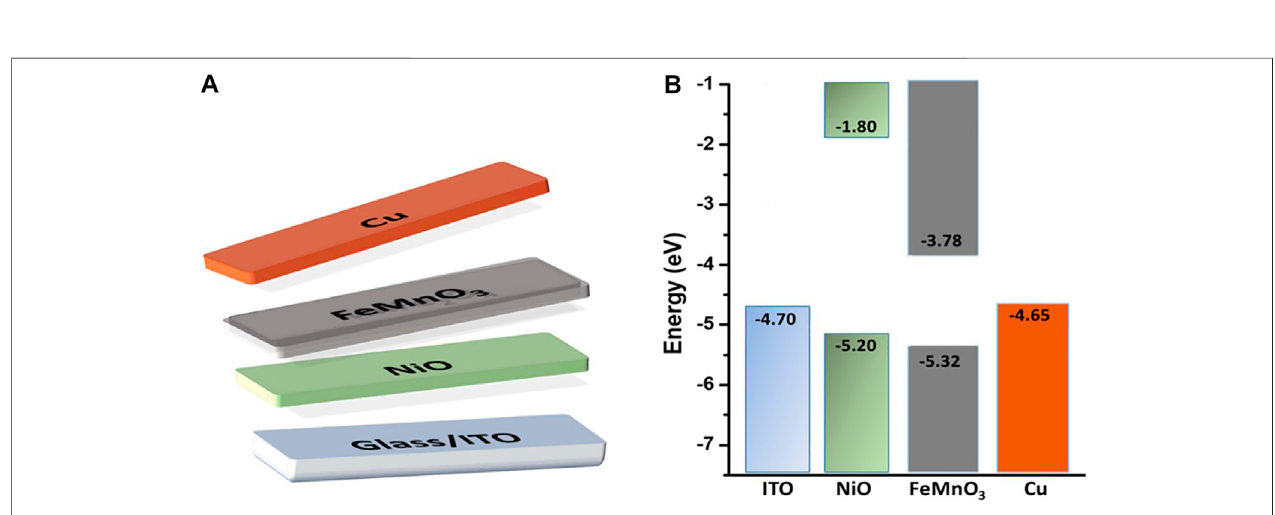
FIGURE 4 | (A) Schematic representation, and (B) the corresponding energy level diagram of each component of the ITO/NiO/FeMnO 3 /Cu device.